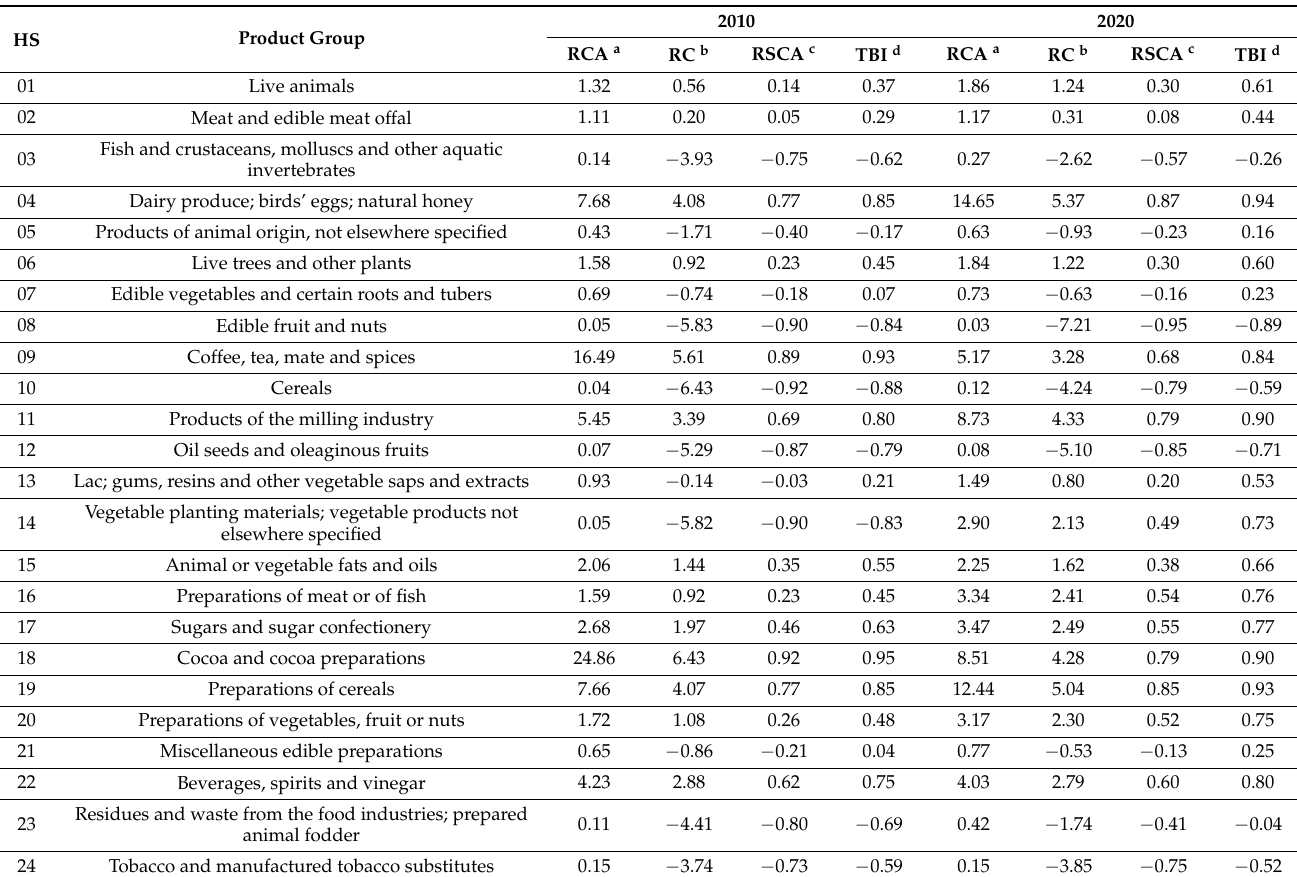
Table 5. Evaluation of the comparative advantages of the EU agri-food sector in relation to the US market in 2010 and 2020 by the Harmonized System (HS)